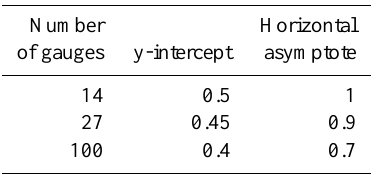
Table 3. Sensitivity analysis. Fitted y-intercept and horizontal asymptote values of coefficients of variation (CV J , in Fig. 13) for different rain gauge networks (Fig. 6b).